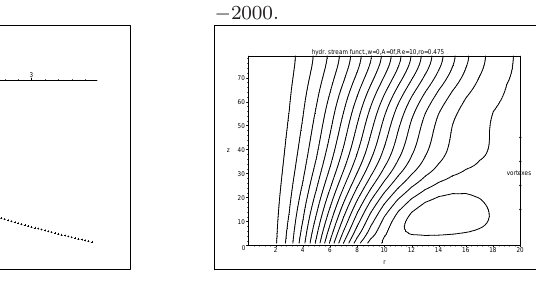
Figure 4. Streamlines of velocity in a pipe with the reduced input, Re = 10 ,A = 0